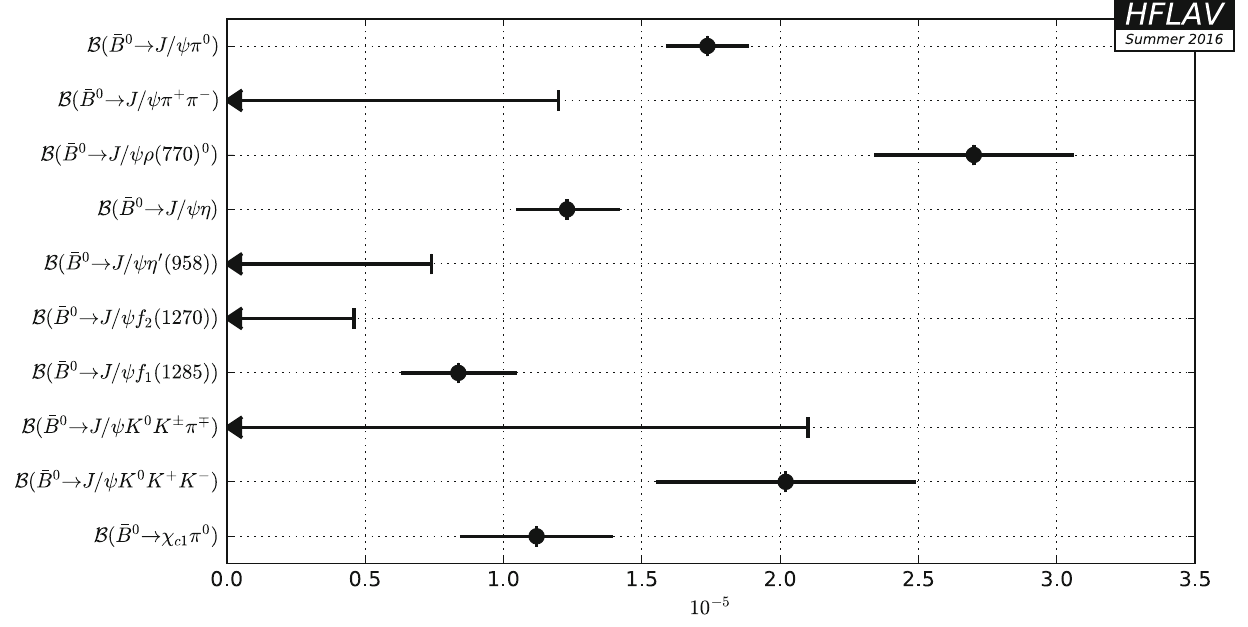
Fig. 93 Summary of the averages from Table 119